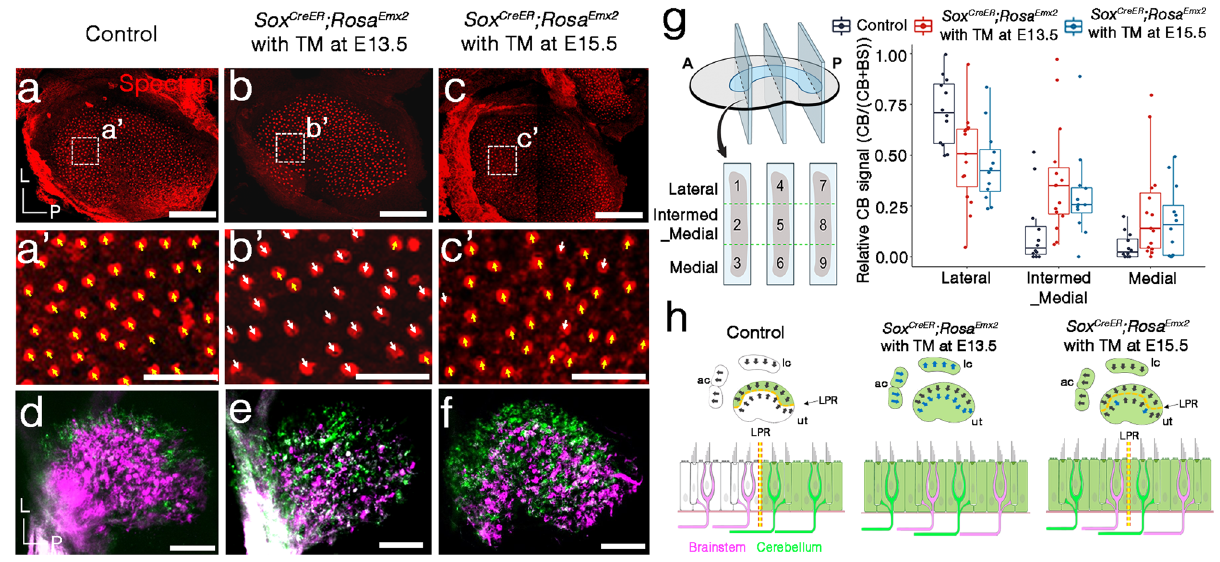
Sox2 CreER ; Rosa Emx2 utricles treated with tamoxifen at E13.5 or E15.5 when